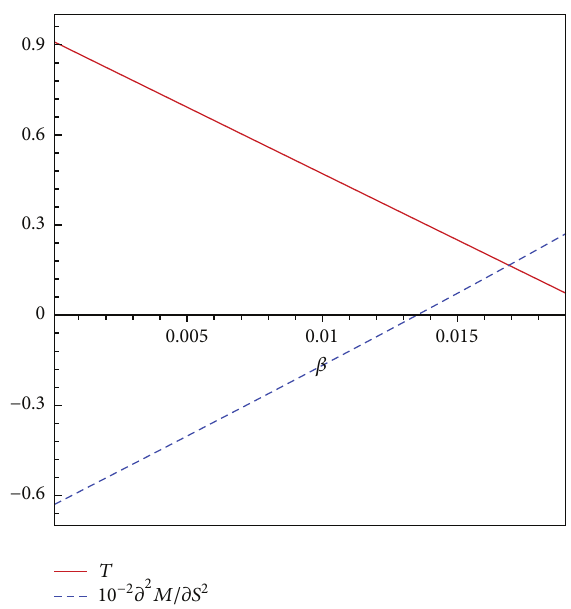
Figure 11: The behaviors of 𝑇 and 10 −2 (𝜕 2 𝑀/𝜕𝑆 2 ) 𝑄, J versus 𝛽 with 𝑙 = 1 , 𝑏 = 0.5 , 𝛼 = 3 , Ξ = 1.25 , 𝑛 = 6 , 𝑞 = 10 , and 𝑟